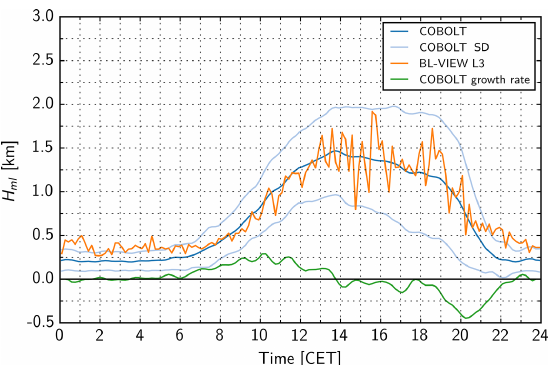
Figure 6. Daily afternoon value of H ml (averaged over 3h starting 30min after noon) as derived from COBOLT (blue dots) and BL- VIEW L3 (orange dots) between 27 June and 2 September 2014. The alignment of the labels of the x axis (date) is defined by the position of the dots separating day and month. The shaded areas highlight days when H ml , v could not be retrieved by applying the L3